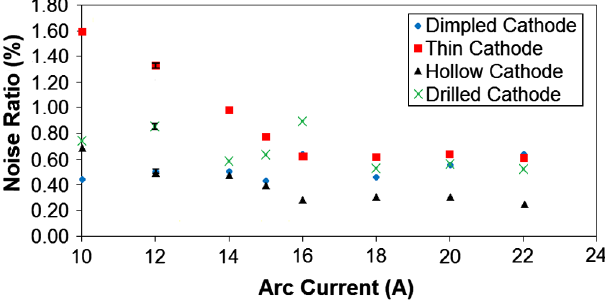
FIG. 19. Noise ratio as a function of arc current for different cathodes. Extraction voltage is − 35 kV.